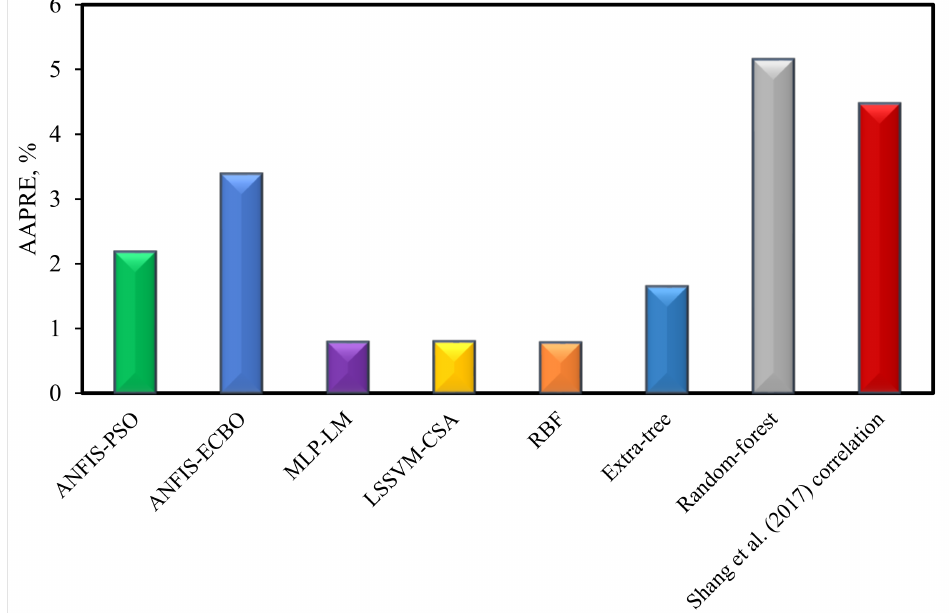
Figure 9. Comparing AAPRE for all available models and correlations for estimating the IFT of N 2 /CO 2 mixture +